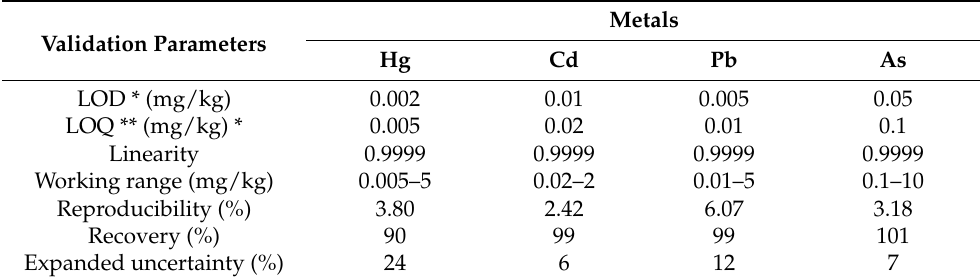
Table 1. Validation parameters of the analytical procedure for the determination of Cd, Pb, As, and